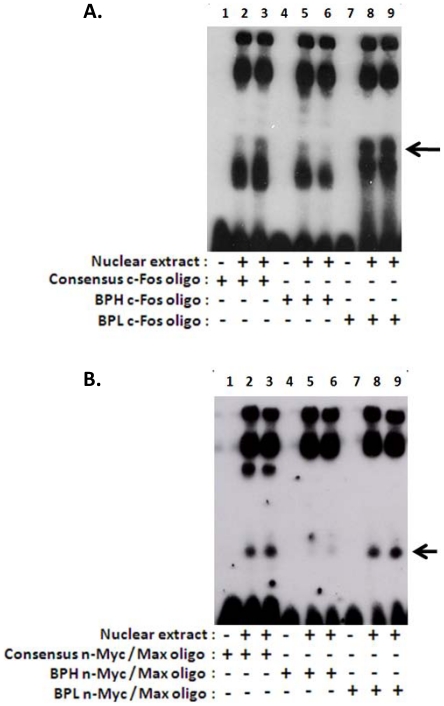
Electrophoretic mobility shift assays demonstrating complex formation between Hmgcr promoter domains and HepG2 nuclear proteins.
Panel A: Oligos harboring the consensus c-Fos motif and the BPL-/BPH- Hmgcr promoter c-Fos motifs were biotinylated and incubated with HepG2 nuclear extracts as described in the Materials and Methods section. The BPL c-Fos oligo displayed dramatically enhanced formation a specific nuclear protein–oligo complex (lanes 8 and 9; indicated by a horizontal arrow) as compared to the BPH c-Fos oligo (lanes 5 and 6). As a negative control, no nuclear extract was added in some of the reactions (lane 1, consensus c-Fos oligo; lane 4, BPH c-Fos oligo; lane 7, BPL c-Fos oligo) to visualize the location of free/unbound probes on the gel. As a positive control, complexes formed by the consensus c-Fos oligo are shown in lanes 2 and 3. The results are representative of at least three separate experiments. Panel B: Oligos harboring the consensus n-Myc/Max motif and the BPL/BPH- Hmgcr promoter n-Myc/Max motifs were biotinylated and incubated with HepG2 nuclear extracts as described in the Materials and Methods section. The BPL n-Myc/Max oligo displayed formation of significantly higher amount of a specific nuclear protein–oligo complex (lanes 8 and 9; indicated by a horizontal arrow) as compared to the BPH n-Myc/Max oligo (lanes 5 and 6). As a negative control, no nuclear extract was added in some of the reactions (lane 1, consensus n-Myc/Max oligo; lane 4, BPH n-Myc/Max oligo; lane 7, BPL n-Myc/Max oligo) to visualize the location of free/unbound probes on the gel. As a positive control, complexes formed by the consensus n-Myc/Max oligo are shown in lanes 2 and 3. The results are representative of at least three separate experiments.